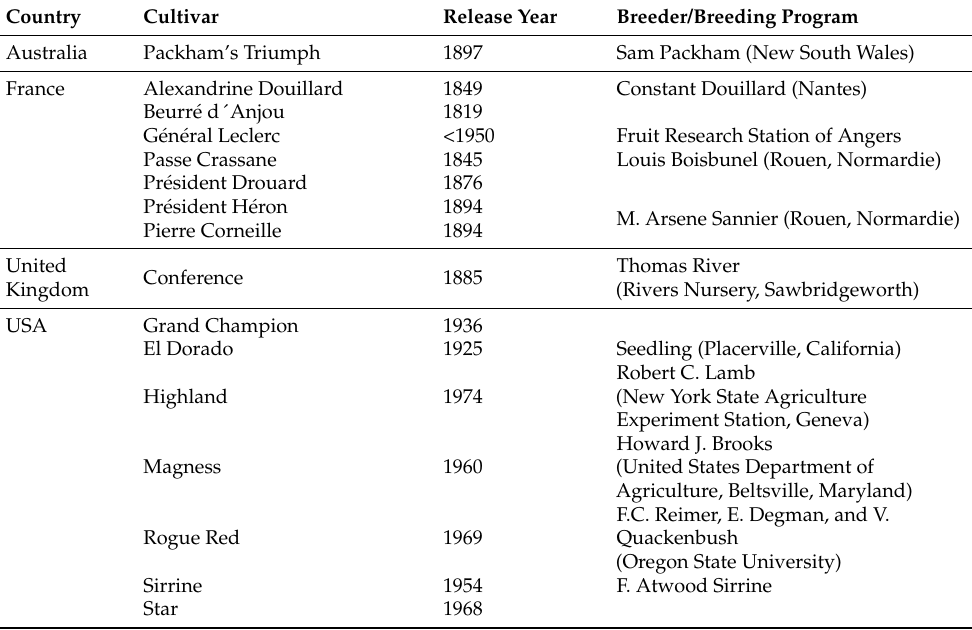
Table 1. Pear cultivars used in this study: country of origin, cultivar name, release year, and breeding program